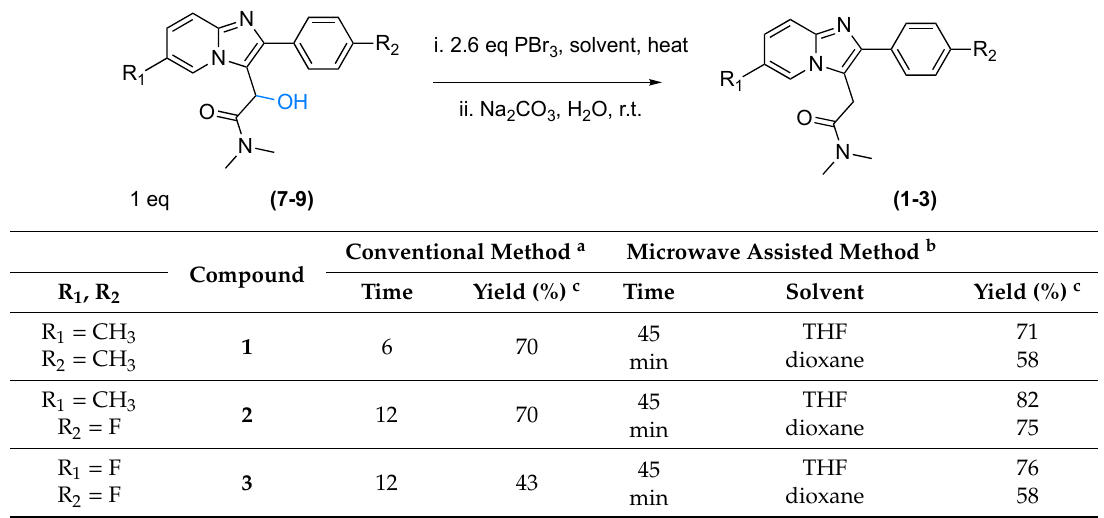
Table 4. Dehydroxylation of α -hydroxyacetamide precursors ( 7 – 9 ) in the presence of PBr 3 and MW in comparison to traditional heating.